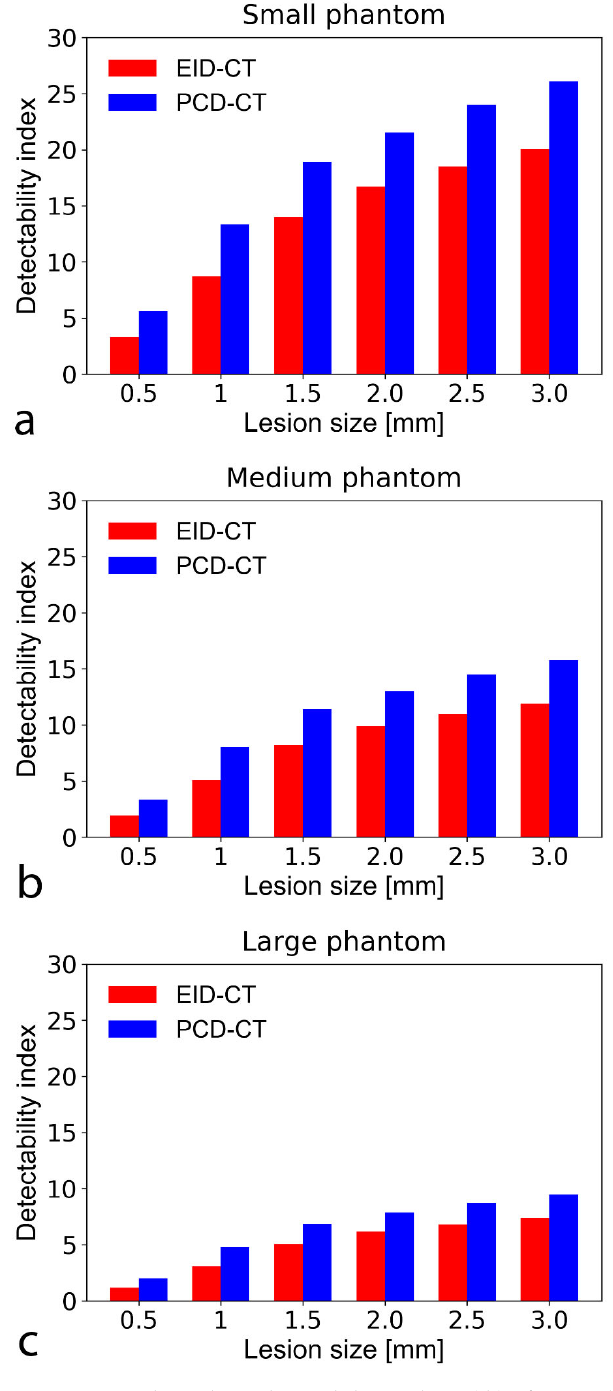
Figure 5. Bar chart show detectability indices (d’) of non ‐ calcified atherosclerotic plaque with an object ‐ to ‐ background contrast | Δ HU| of 450 HU and CTDI = 10 mGy in the small ( a ), medium ( b ), and large sized ( c ) phantom setup. A d’ of 2 corresponds to 90% accuracy (AUC). The SPCCT consistently provided higher detectability indices than the conventional system. Note that at large phantom size, only the PCD ‐ CT system could accurately detect (i.e., with a d’ ≥ 2 indicating an AUC of 90%) the smallest simulated plaque (0.5 mm). CTDI—computed tomography dose index; PCD ‐ CT—photon ‐ counting detector computed tomography. CTDI—computed tomography dose index; EID ‐ CT—energy ‐ integrating detector computed tomography; AUC—area under the curve.